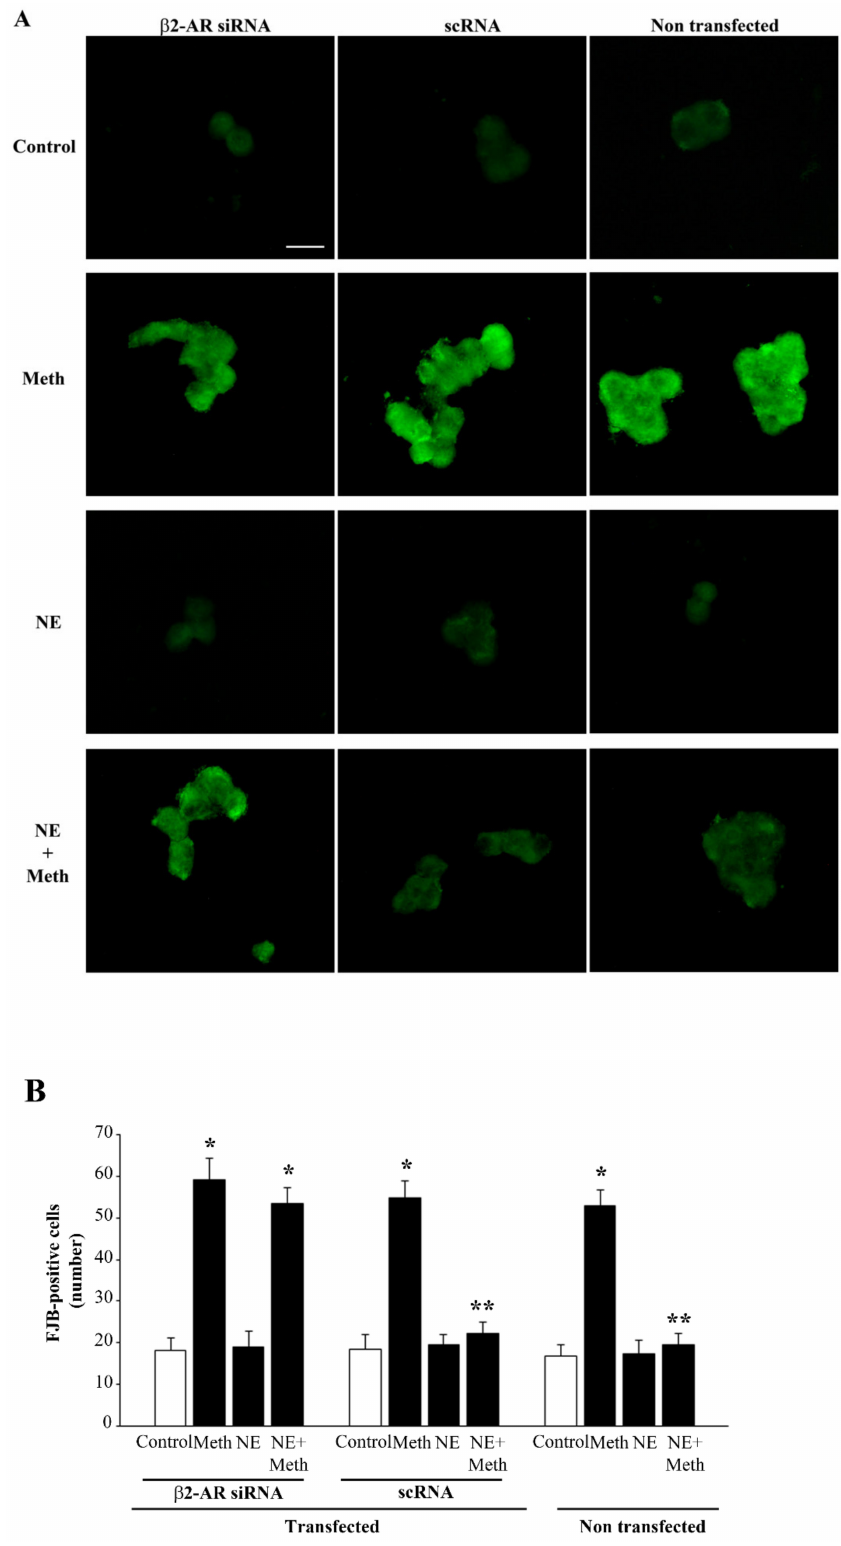
Figure 11. Meth-induced FJB fluorescence is not reduced by NE after transfection with β 2-AR siRNA. ( A ) Representative pictures and FJB fluorescent cells showing the effects of Meth and NE in naïve and β 2-AR siRNA- and scRNA-transfected cells. ( B ) The graph reports the number of FJB fluorescent cells in the different experimental groups. (DF = 11) * p < 0.05 compared with control; ** p < 0.05 compared with Meth. Scale bar = 13.3 µ